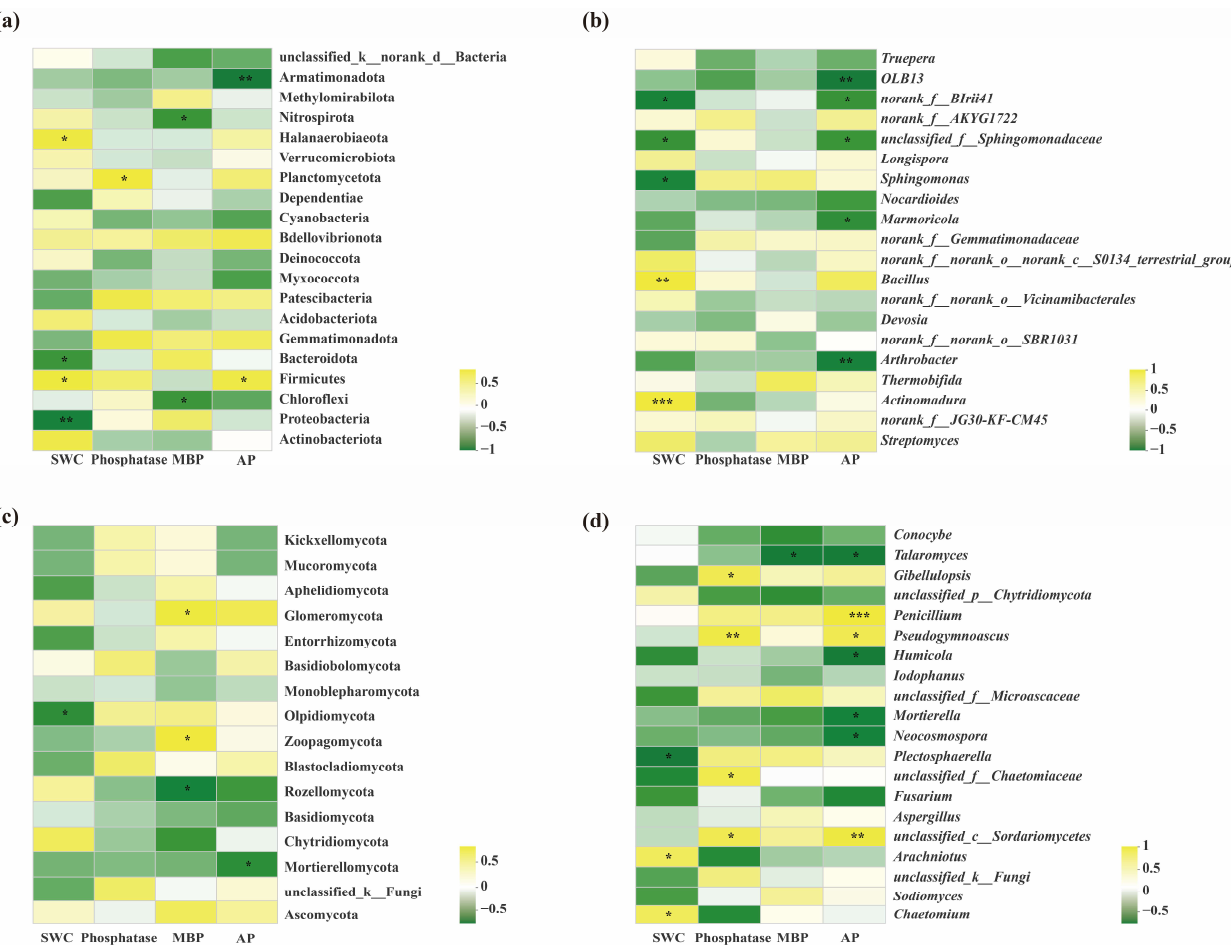
Figure 8. Heatmap correlation analysis between edaphic physicochemical factors and the bacterial population of oilseed rape in the RR, RL and CK. ( a ) Soil bacterial population at the phylum level; ( b ) Soil bacterial population at the genus level; ( c ) Soil fungal population at the phylum level; ( d ) Soil fungal population at the genus level. R values are shown in the figure with shades of color, and they are marked with *, ** or *** if the p values are less than 0.05, 0.01, 0.001, respectively. SWC, soil water content; MBP, microbial biomass phosphorus; AP, available phosphorus.At the genus level, only SWC and AP had significant effects on soil bacterial community compositions., i.e., SWC showed a significant positive correlation with Actinomadura and Bacillus . Meanwhile, SWC also showed a significant negative correlation with Sphingomonas , unclassified_f__Sphingomonadaceae and norank_f__BIrii41 . Furthermore, AP also showed a significant negative correlation with no- rank_f__BIrii41 , unclassified_f__Sphingomonadaceae , and Marmoricola , and an extremely significant negative correlation with OLB13 and Arthrobacter (Figure